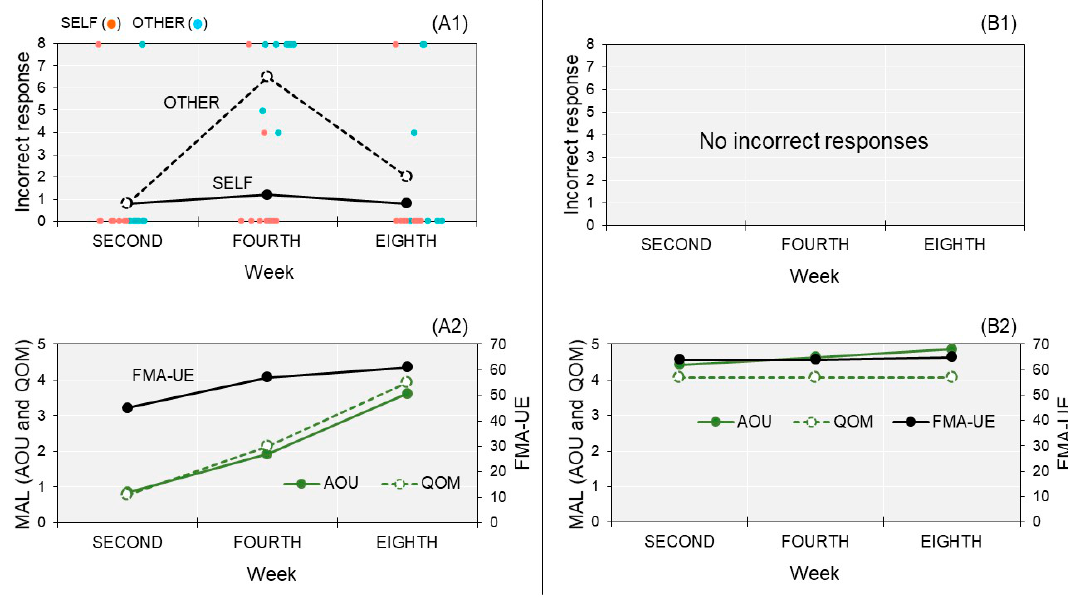
Figure 4. Incorrect responses (i.e., misattributions) and paretic upper limb function/activity for each experiment week (second, fourth, and eighth). A1 and A2 show the data of PA. B1 and B2 show the data of PB. In A1, the orange and blue points show the data of each trial.